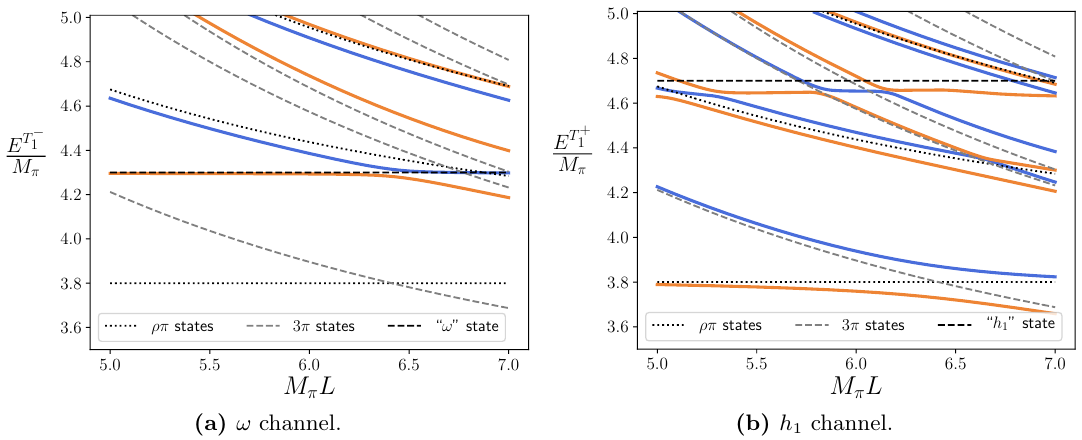
Figure 4 . Illustrative (cid:12)nite-volume spectra for three pions with I (cid:25)(cid:25)(cid:25) = 0 and irreps (a) T (cid:0) (b) T + , plotted versus M (cid:25) L . The interacting spectrum is shown by solid lines, with the alternating 1 orange and blue colors only used to distinguish adjacent levels. Dashed and dotted grey lines show the comparison with di(cid:11)erent noninteracting levels. The parameters used for described in the